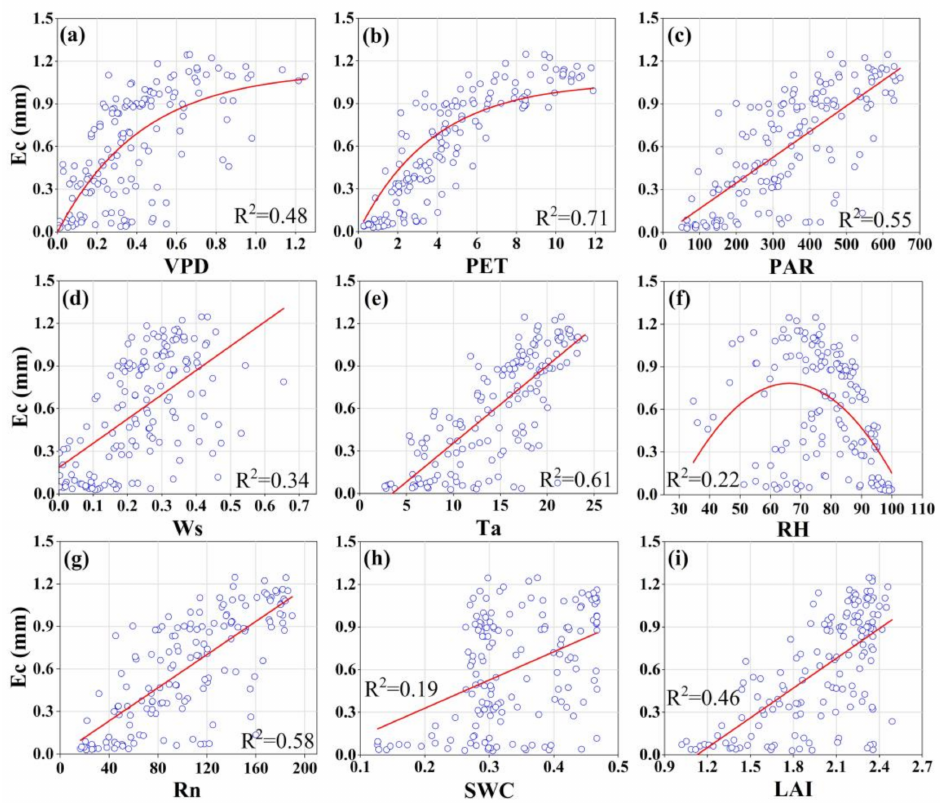
Figure 7. Plot exhibiting the function relationships between environmental factors and Ec in the growing season. ( a ) VPD; ( b ) PET; ( c ) PAR; ( d ) Ws; ( e ) Ta; ( f ) RH; ( g ) Rn; ( h ) SWC; ( i ) LAI.